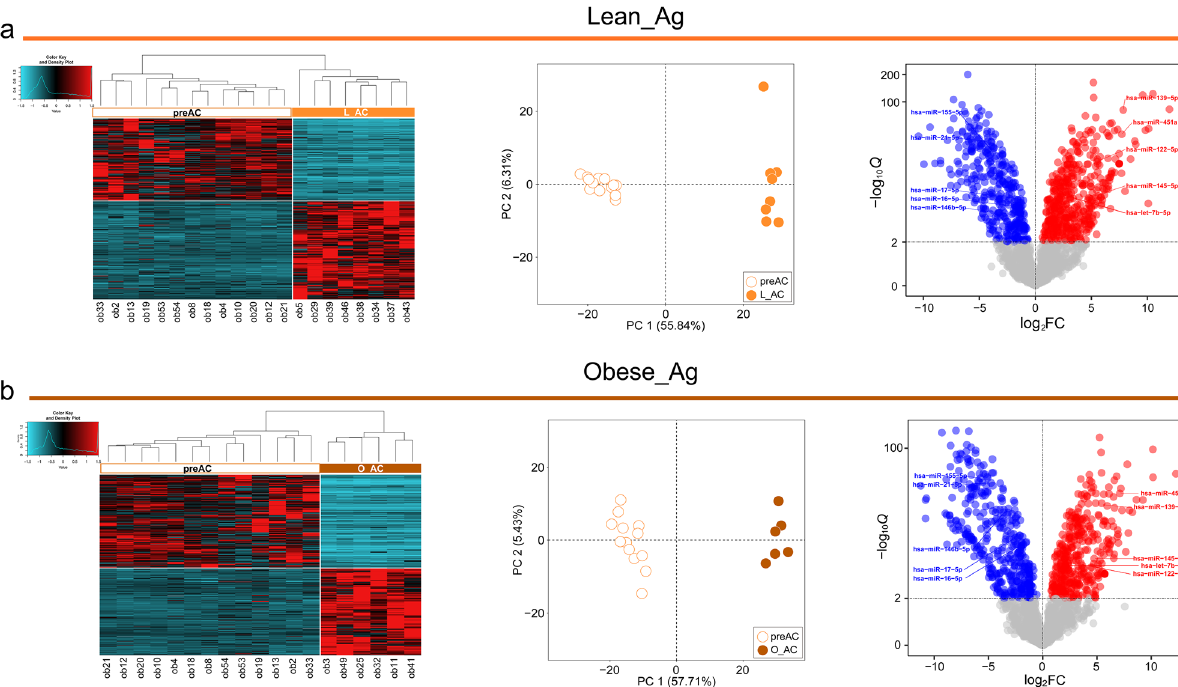
Figure 2. Expression patterns of DEMs detected in L_Ag and O_Ag. ( a ) (left) Heatmap for Z score scaled expression patterns of DEMs identified in L_Ag, (middle) PCA of preACs and L_ACs, (right) Volcano plot representing the differential expression of miRNAs in L_ACs compared to preACs. The details of the heatmap, PCA plot, and volcano plot are the same as in Fig. 1a–c, respectively. ( b ) (left) Same as the left panel of ( a ) but for O_Ag, (middle) Same as the middle panel of ( a ) but for preACs and O_ACs, (right) Same as the right panel of ( a ) but for preACs and